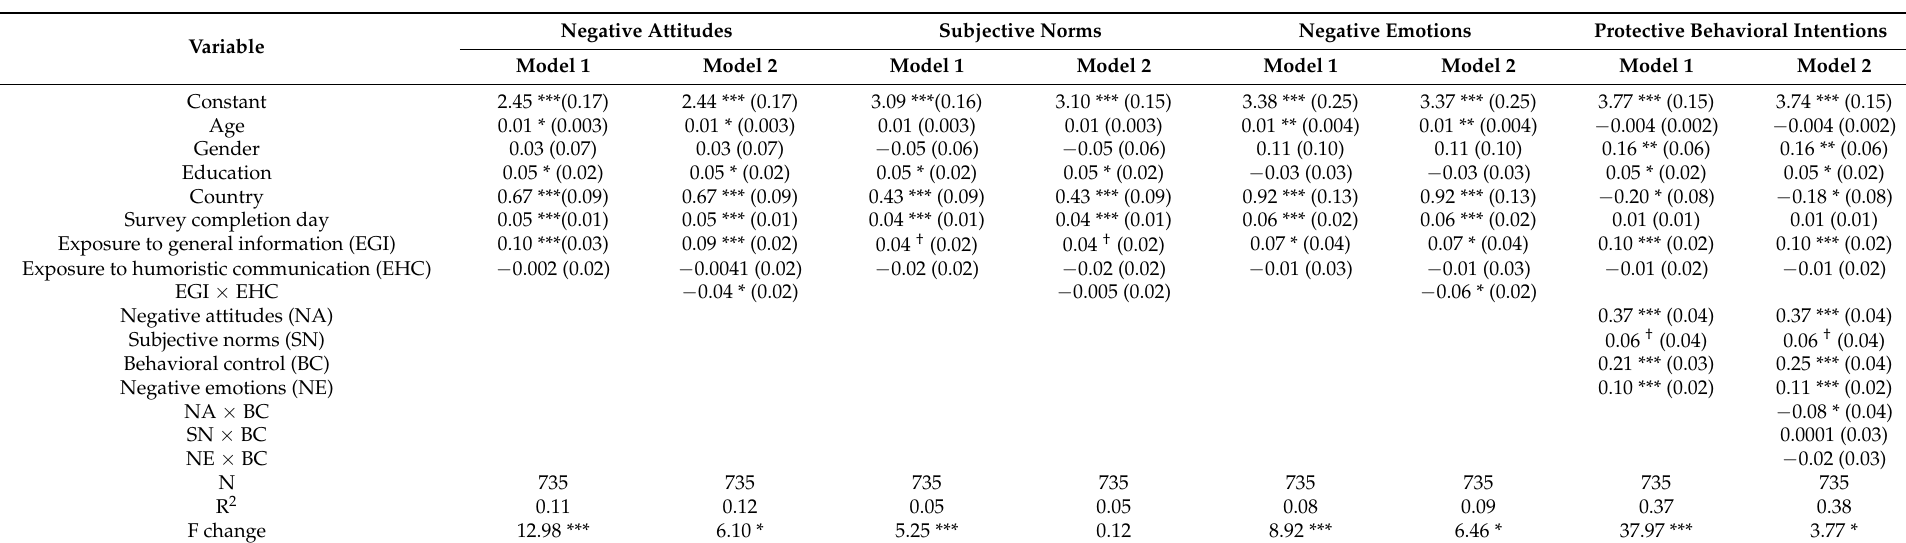
Table 2. Results of the regression analyses with robust standard